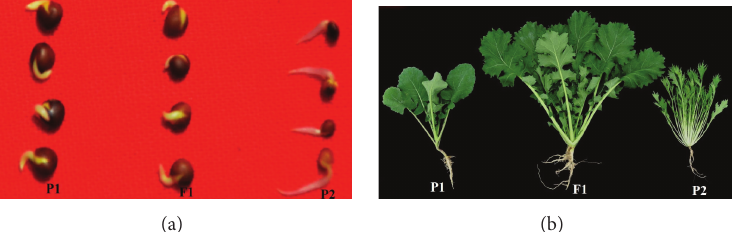
Figure 2: Seed germination (a) and 2-week-old seedlings (b) of P1, P2, and F1